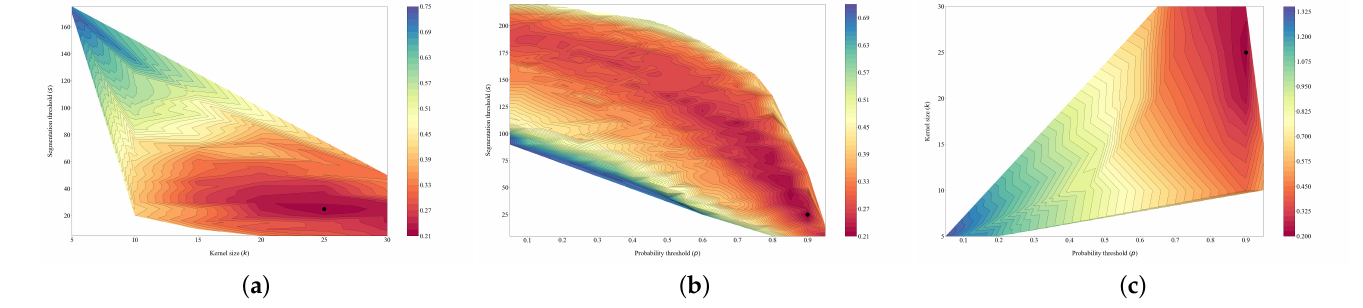
Figure 9. Graphical representation of the redefined function F associated with capture 0, fixing one of the parameters in each case. It is observed how the domain of the function changes when it is redefined. The black dot represents the minimum value of the function. ( a ) p = 0.9. ( b ) k = 25. ( c ) s =